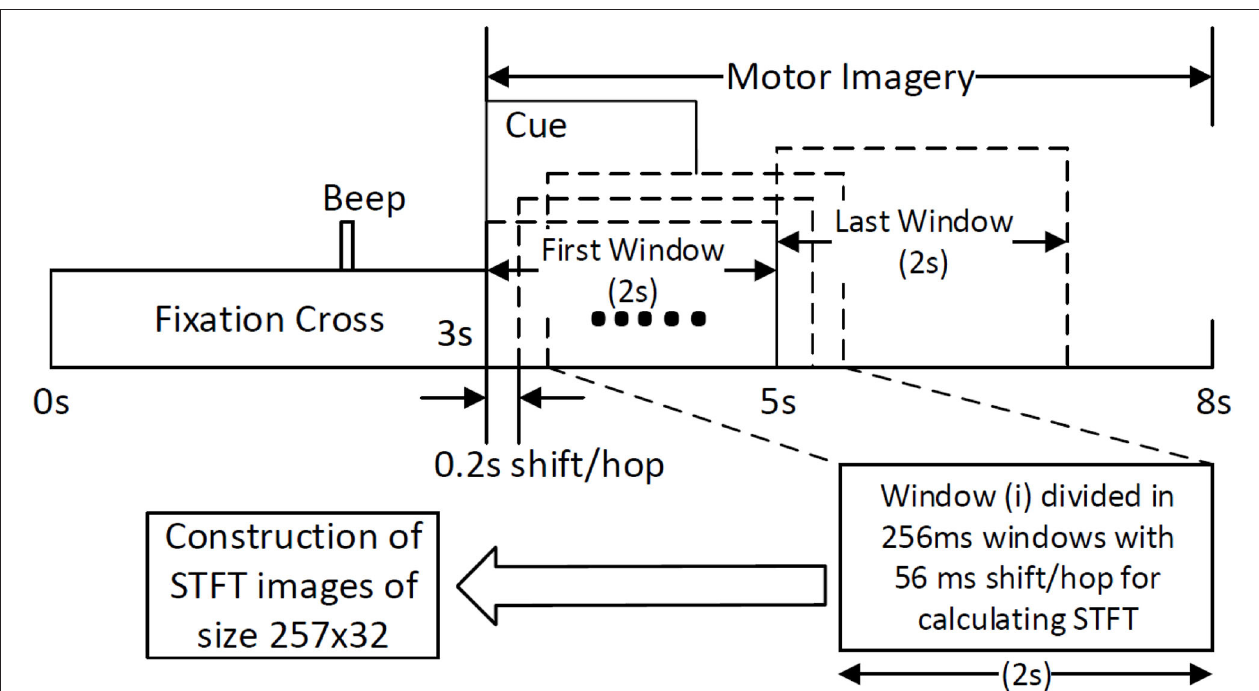
FIGURE 1 | Construction of STFT images by sliding window of size 2 s with a shift/hop of 200 ms is divided into 256 ms sub-windows (with 56 ms shift/hop) for calculating STFT of the MI period within the